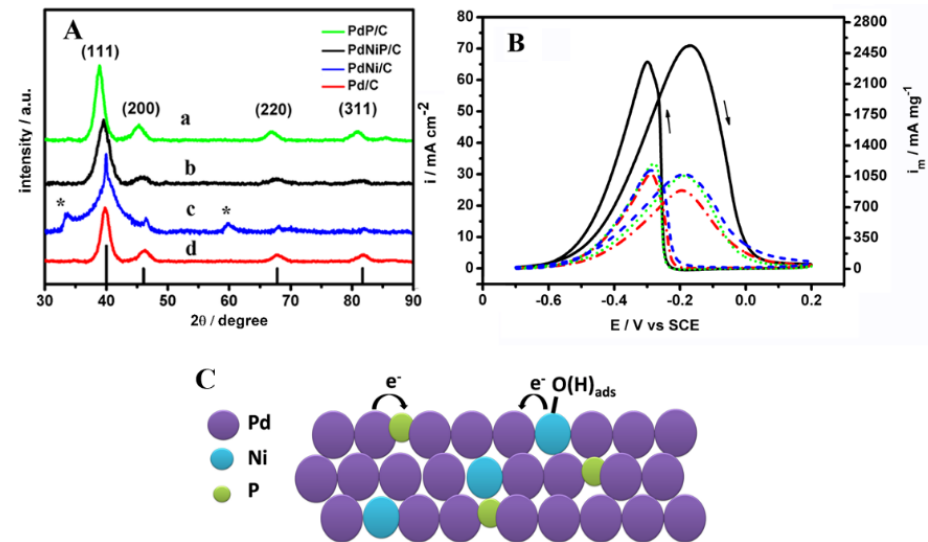
Figure 12. ( A ) XRD patterns of the Pd–P/C (curve a), Pd–Ni–P/C (curve b), Pd–Ni/C (curve c) and Pd/C (curve d). ( B ) Cyclic voltammograms for Pd-based catalysts in 0.5 M NaOH and 1 M C 2 H 5 OH at 50 mV·s −1 ; ( C ) Scheme of Pd–Ni–P atomic arrangement. The asterisks at 33.5° and 59.2° mark the peaks from Ni(OH) 2 (100) and (110) facets. Reprinted and adapted with permission from Reference [117]. Copyright 2013,